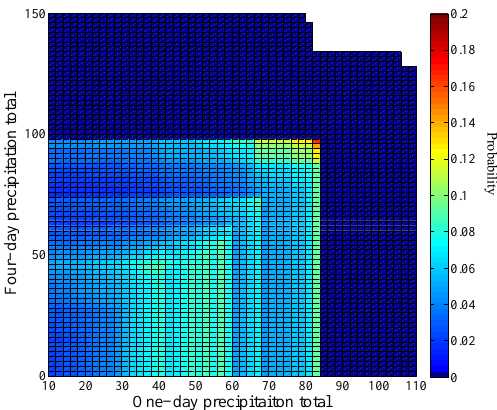
Figure 6. Probability of a flash event based on 1- and 4-day pre- cipitation totals from a local rain gauge. Dark blue indicates zero probability of occurrence.